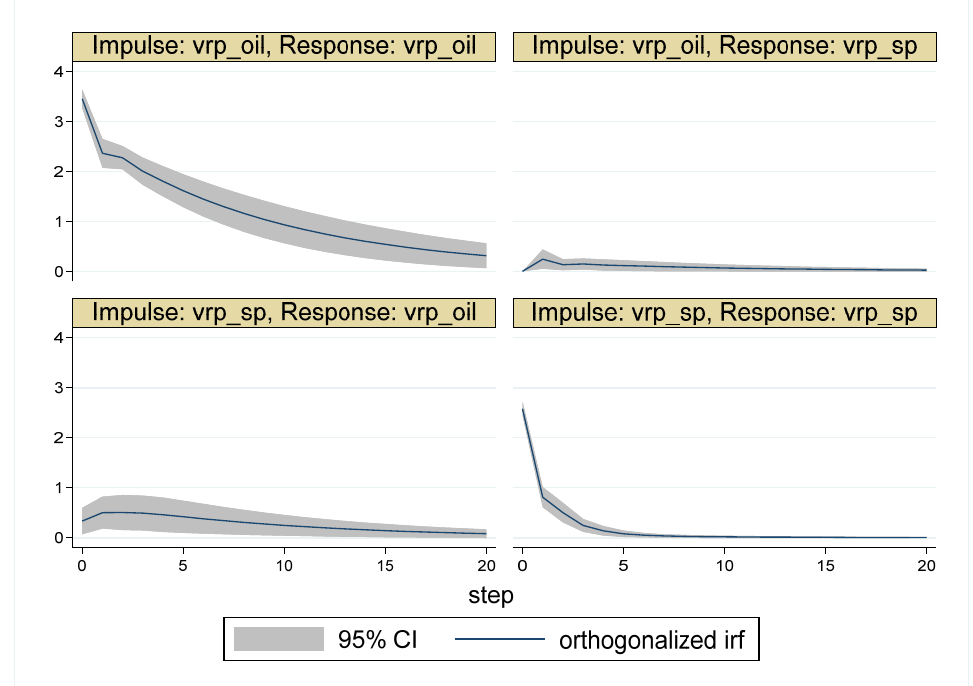
Figure 13. Impulse Response Function with Order VRP sp before VRP oil (Period 5). Notes: Vrp_oil (resp. vrp_sp) represents volatility risk premium of oil (resp. stock). The solid line represents orthogonalized impulse response functions and the gray area represents their 95% confidence interval. The above-right graph shows the impulse response functions of vrp_sp to vrp_oil. The below-left graph shows the impulse response functions of vrp_oil to vrp_sp. Table 9. Variance decompositions with order VRP (cid:2929)(cid:2926) before VRP (cid:2925)(cid:2919)(cid:2922) . (Effects on the 20th trading day after the shock).